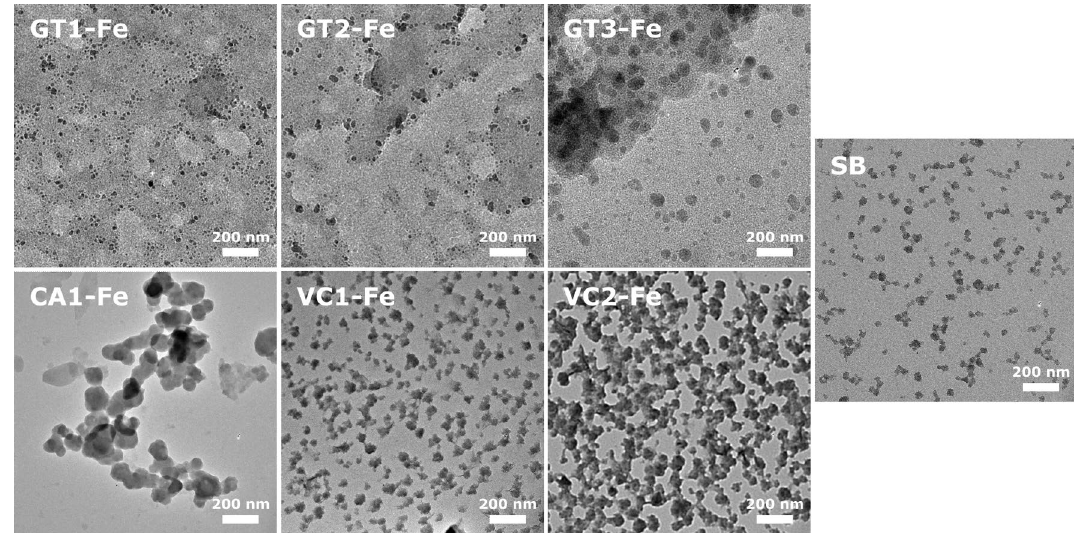
Fig. 4 TEM images of iron nanoparticles produced by using various green waste extracts obtained in three extraction rounds of green tea (GT1-Fe, GT2-Fe, and GT3-Fe), first round of coffee (CA1-Fe), first and second rounds of Virginia creeper (VC1-Fe, VC2-Fe), and by chemical method using sodium borohydride